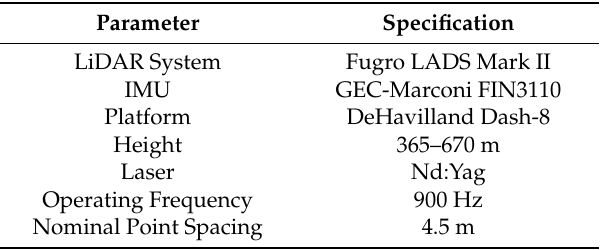
Table 1. Specifications for Fugro LADS Mark II device.